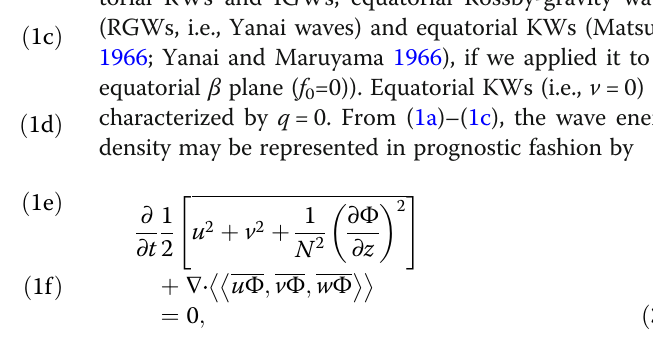
Table 2 List of symbols used in Section 2.1, where A is arbitrary quantities written dimensionally. The coordinate axes x , y , z increase eastward, northward, and vertically upward, respectively p ffiffiffiffiffiffiffiffiffiffiffiffiffiffiffiffiffiffiffiffiffiffiffiffiffiffiffiffiffiffiffiffi Þð d ρ = dz Þ − ð g = ρ 0 Cartesian coordinates 〈〈 a , b , c 〉〉 Vector with x , y and z -axis components a , b , and